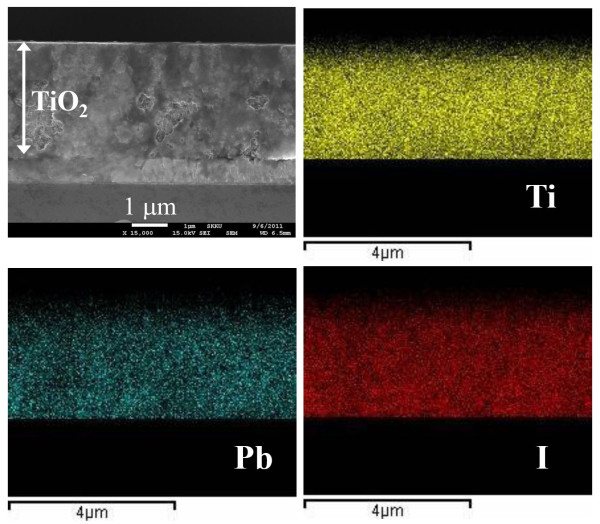
Cross-sectional SEM micrographs of (CH3CH2NH3)PbI3-deposited TiO2film and EDS maps for titanium, lead, and iodine.